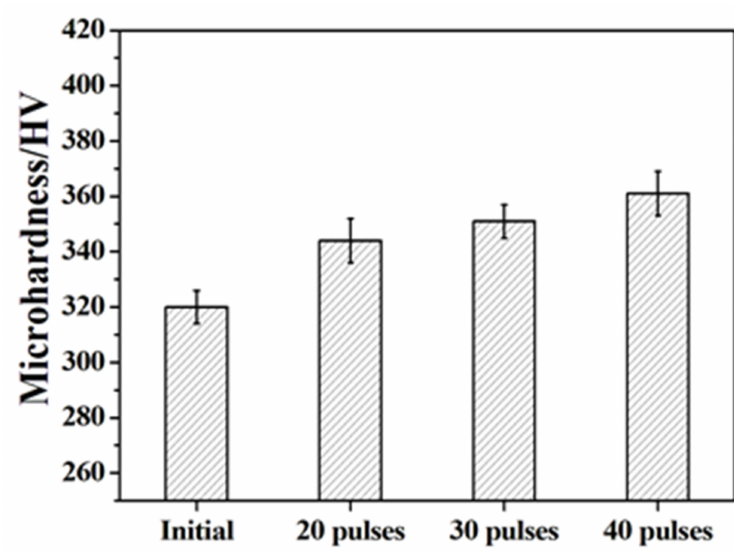
Figure 6. Microhardness measurement of initial and Nb-alloyed